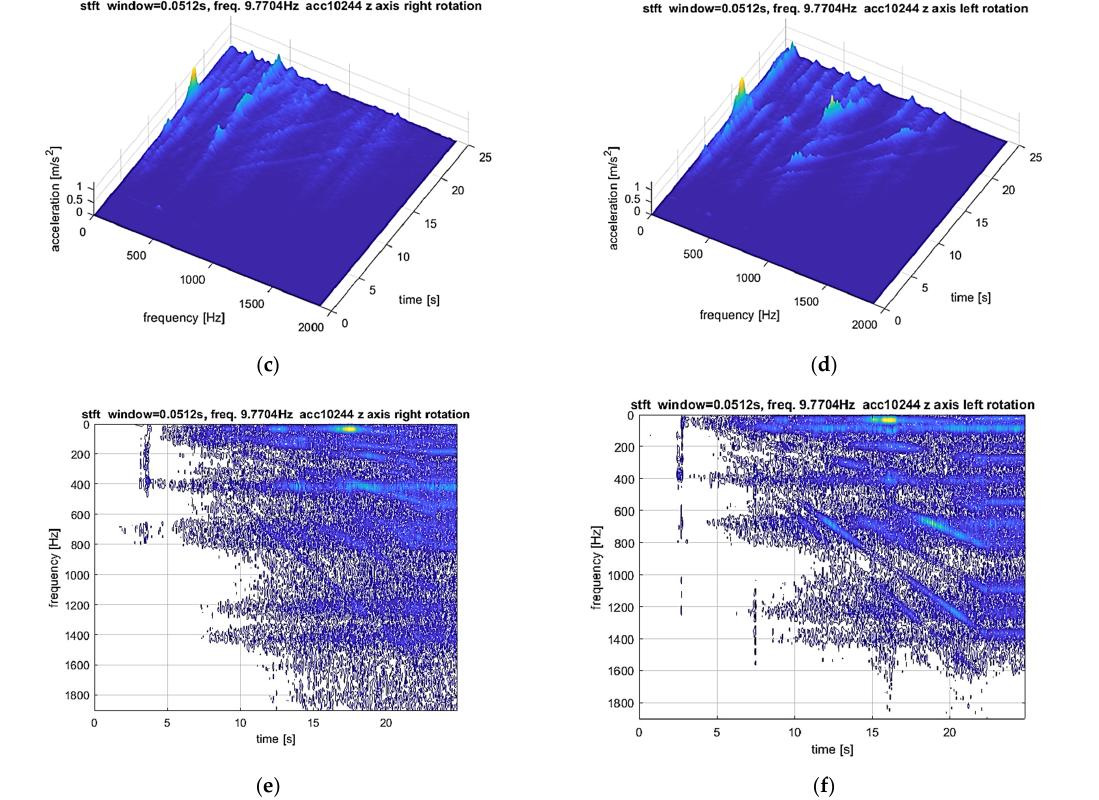
Figure 11. ( a ) Vibration waveform: flexible coupling, direction (axis) z; ( b ) vibration waveform: locked coupling, direction (axis) z; ( c ) 3-D STFT: flexible coupling, direction (axis) z; ( d ) 3-D STFT: locked coupling, direction (axis) z; ( e ) map of STFT: flexible coupling, direction (axis) z; and ( f ) map of STFT: locked coupling, direction (axis) z.